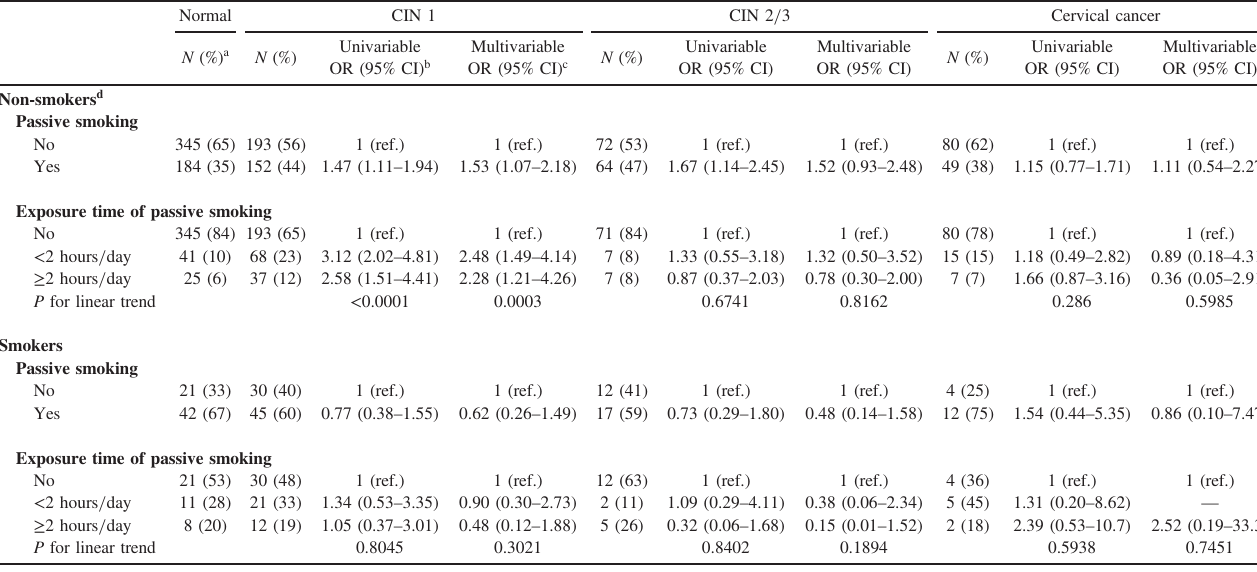
Table 3. Association of passive smoking with the risk of CINs and cervical cancer according to smoking habits of study participants